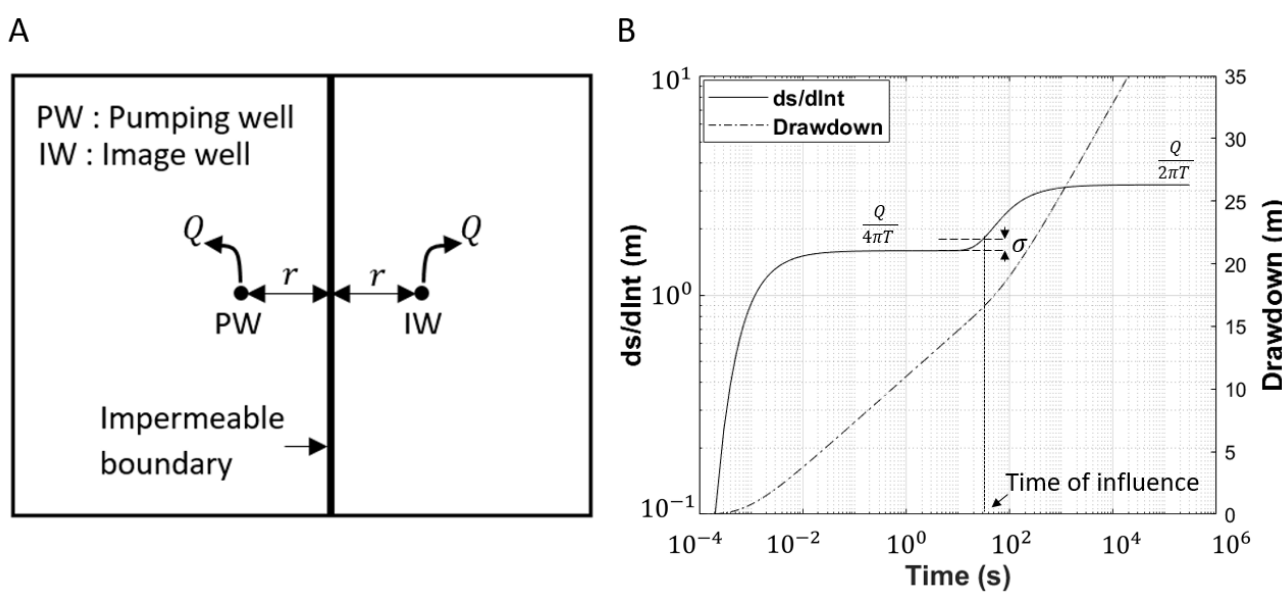
Figure 8. ( A ) Aquifer conceptual model with linear impermeable boundary. ( B ) Drawdown 𝑠(𝑟, 𝑡) and log-derivative 𝑑𝑠/𝑑𝑙𝑛𝑡 curves.